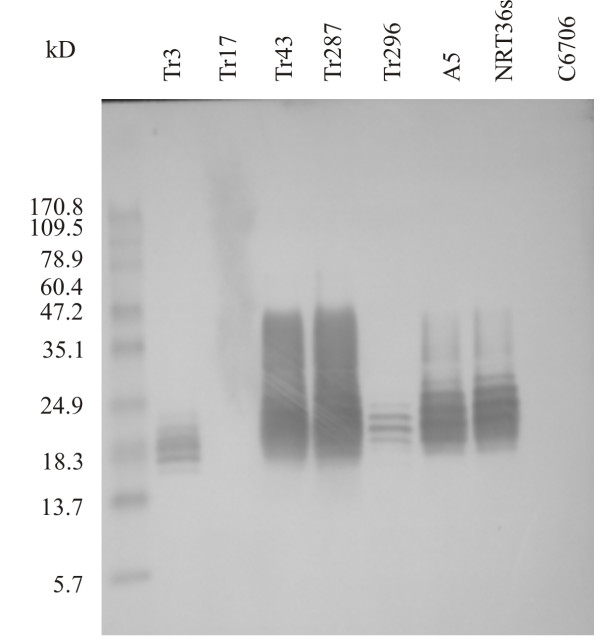
Immuno blot of NRT36S antiserum against external polysaccharide preparations from various strains.